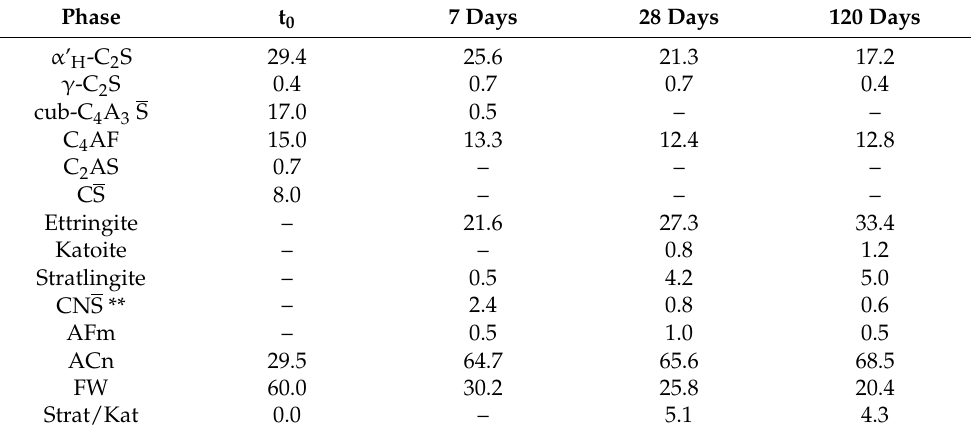
Table 8. RQPA, including ACn and FW of B-BYF with w/c = 0.60 (B-BYF-wc060), per 100 g of anhydrous cement. Stratlingite/katoite ratio is also included. Phase t 0